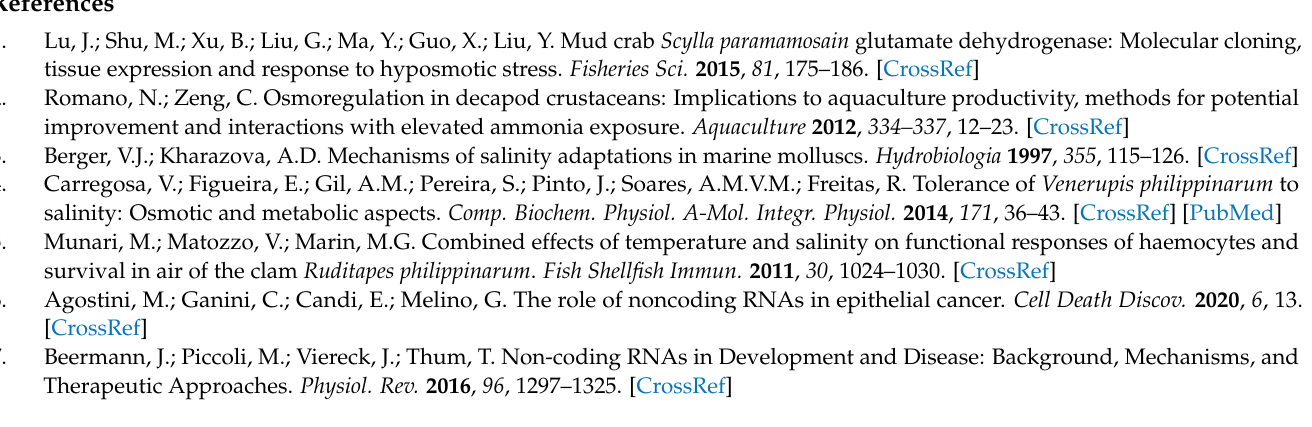
Figure S2: Volcano Plot pictures showing log 2 FC and − log 10 Pvalue of mRNA, Figure S3: GO and KEGG pathway analyses of DEGs under salinity stress, Figure S4: Volcano Plot pictures showing log 2 FC and − log 10 Pvalue of lncRNA, Figure S5: GO and KEGG pathway analyses of DELs under salinity stress, Figure S6: Volcano Plot pictures showing log 2 FC and − log 10 Pvalue of circRNA, Figure S7: GO and KEGG pathway analyses of DECs under salinity stress, Figure S8: Volcano Plot pictures showing log 2 FC and − log 10 Pvalue of miRNA, Figure S9: Heat map of all DEMis, Figure S10: GO and KEGG pathway analyses of DEMis under salinity stress; Table S1: KEGG pathway analyses of DEGs under salinity stress, Table S2: Annotation analyses of DEGs under salinity stress, Table S3: KEGG pathway analyses of DELs under salinity stress; Table S4: MiRNA target gene